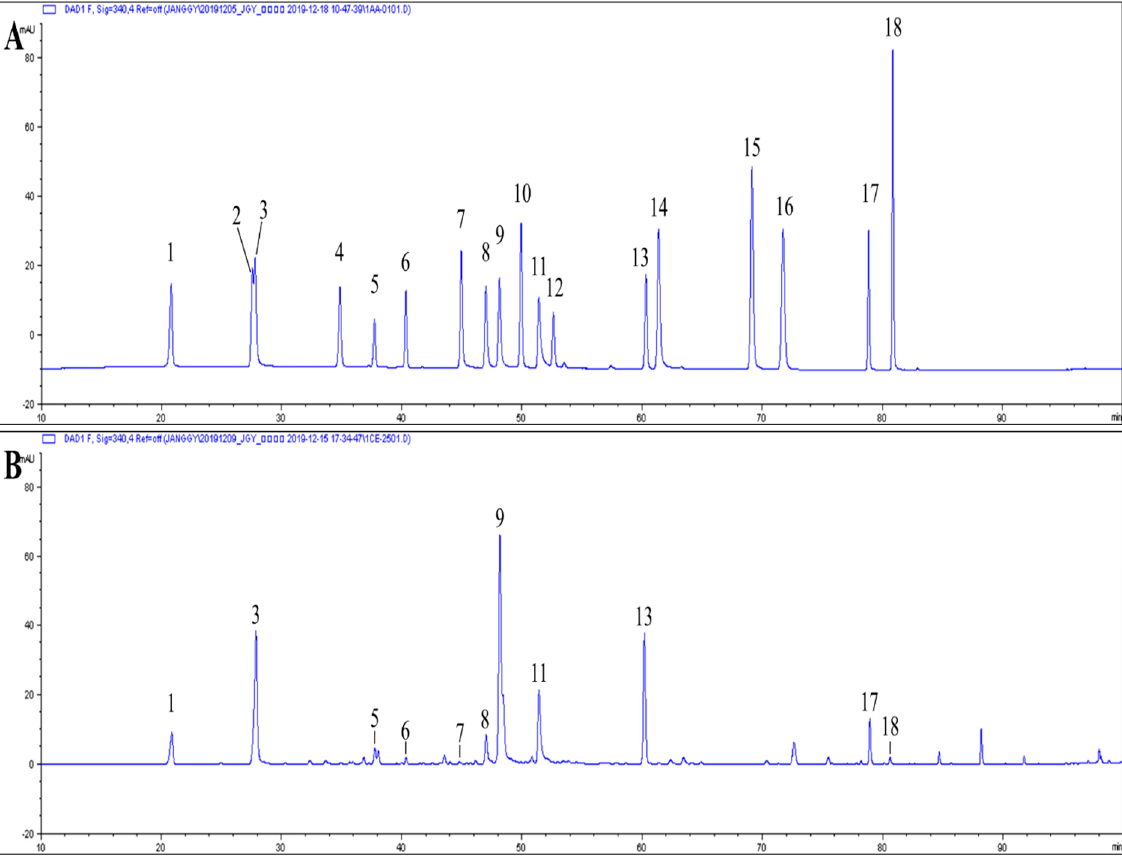
Figure 7. Typical chromatograms of Dendranthema zawadskii (DZ) extract using a HPLC–UVD. ( A ) Standards (1: neochloro- genic acid; 2: chlorogenic acid; 3: 4- O -caffeoylquinic acid; 4: 1,3-di- O -caffeoylquinic acid; 5: vicenin-1; 6: isoschaftoside; 7: luteolin 7- O -glucoside; 8: isochlorogenic acid B; 9: isochlorogenic acid A; 10: apigenin 7- O -glucoside; 11: isochlorogenic acid C; 12: diosmetin 7- O -glucoside; 13: linarin; 14: luteolin; 15: apigenin; 16: diosmein; 17: eupatorin; 18: acacetin); ( B ) DZ extract. Table 1. Major phenolic compounds of Dendranthema zawadskii (DZ) extract.